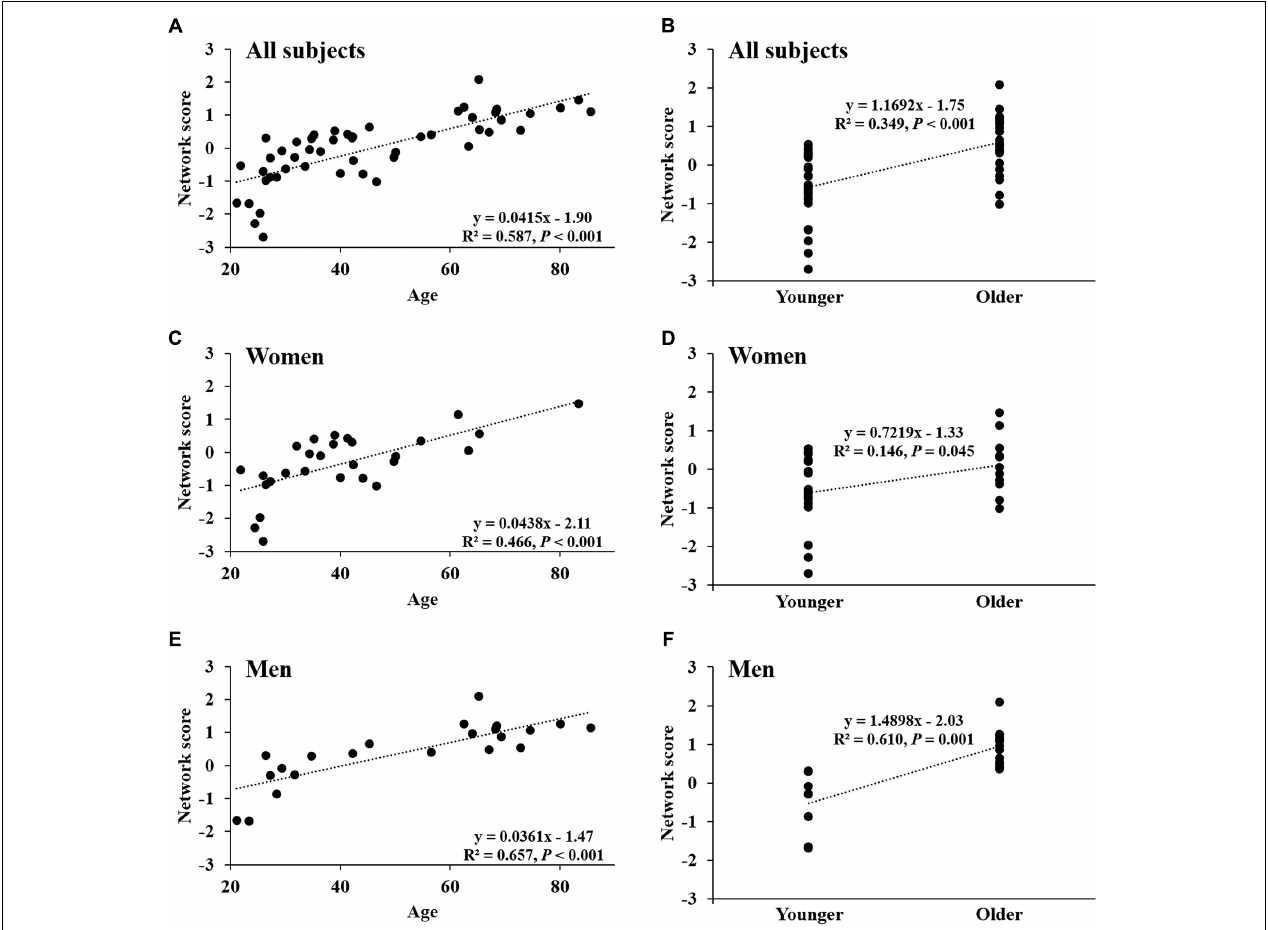
FIGURE 4 | Network score of age-related CBF pattern. (A) Network score in relation to age in all healthy participants. (B) Differences in network score between older subjects and younger subjects in all healthy participants. (C,D) Network score in relation to age, and differences in network score between older subjects and younger subjects in women. (E,F) Network score in relation to age, and differences in network score between older subjects and younger subjects in